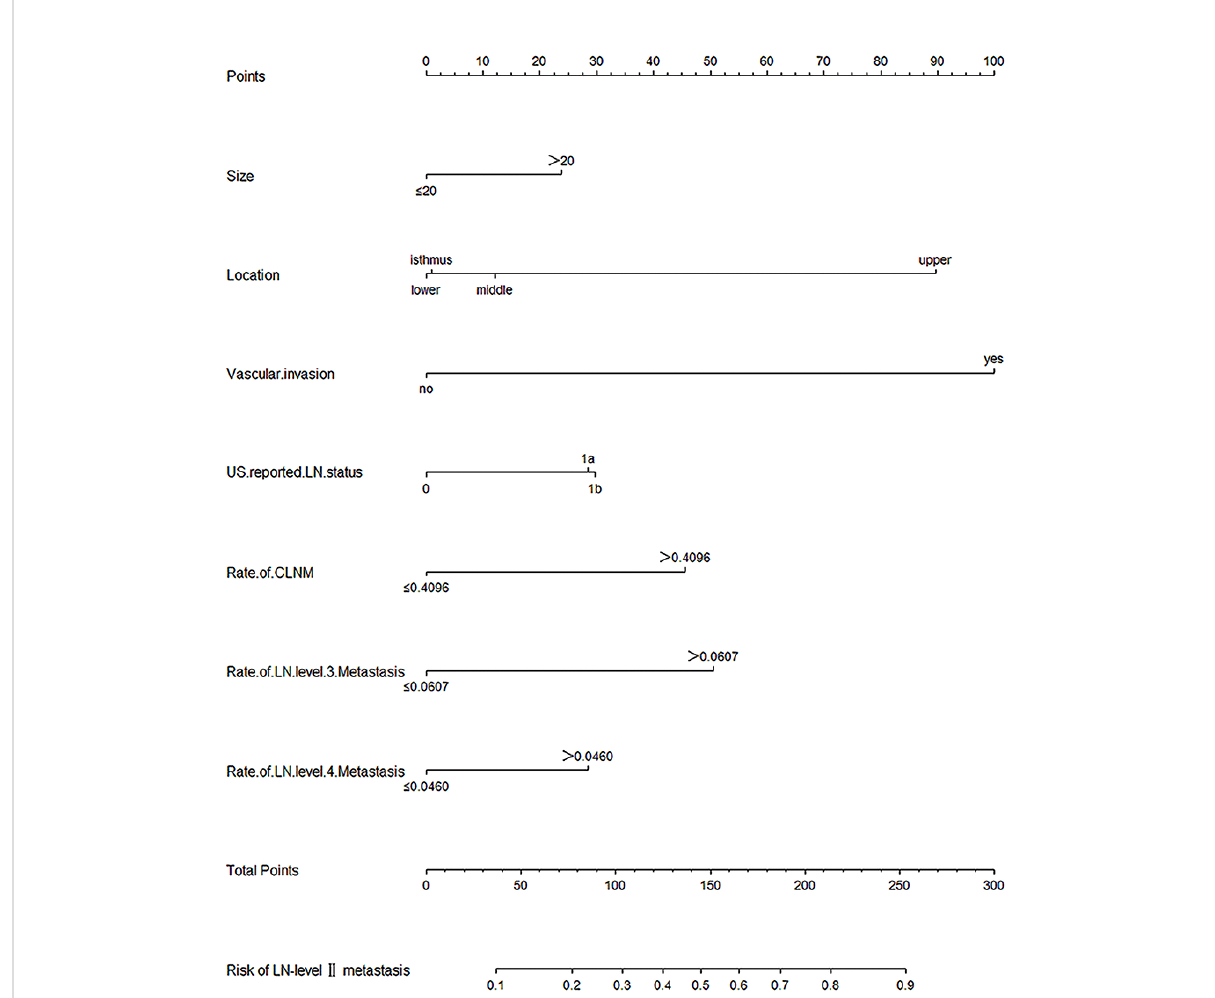
FIGURE 1 Nomogram for prediction of LN-level II metastasis. A line is drawn straight up to the point axis that corresponds with each patient variable to obtain the points. The sum of these points is located on the total score points axis. A line is drawn downwards to the risk axis to determine the possibility of LN-level II